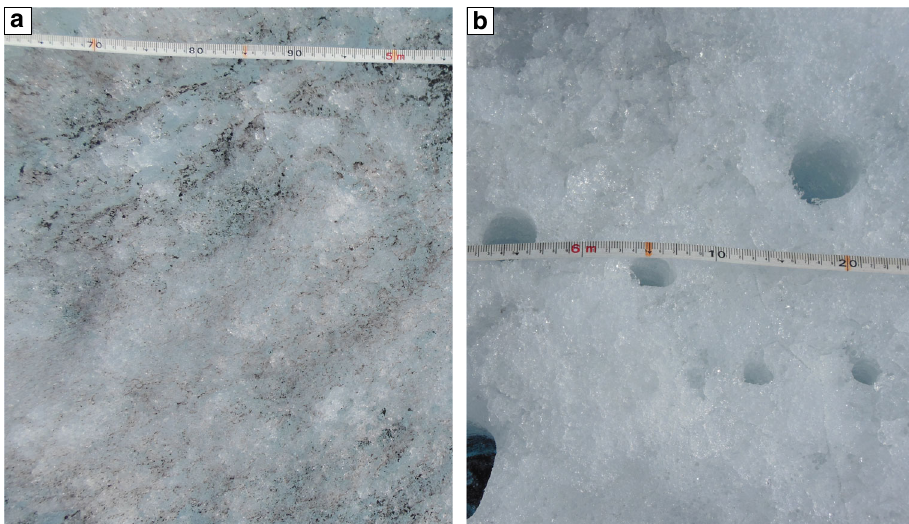
Fig. 4 Photograph showing close-up of bare ice found in the ablation zone. The photographs were taken near the fi eld camp located close to the S6 automated weather station at ~1000 m a.s.l. (Fig. 1). a Ice containing distributed impurities on the surface and b clean ice with cryoconite holes